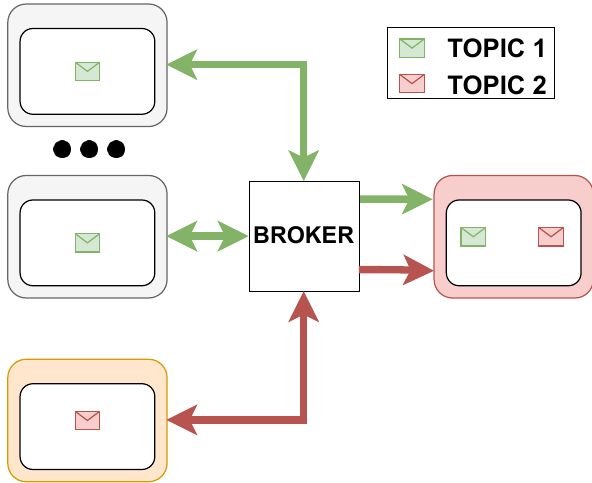
Figure 8. MQTT-SN information leak scheme.